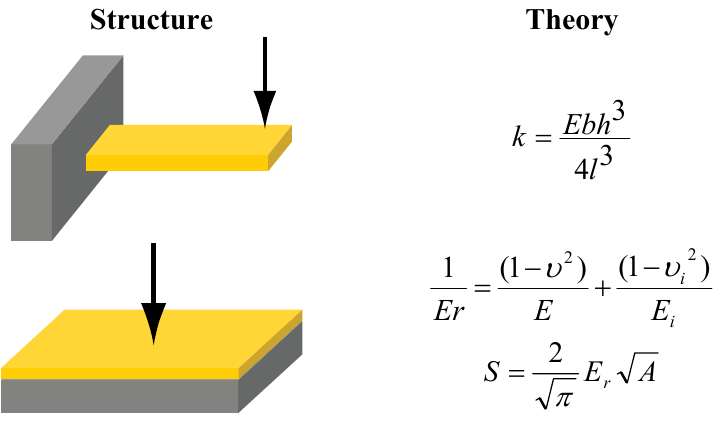
Figure 10. Illustration of various mechanical characterization methods and structure employed. In the cantilever elastic modulus calculation, E is elastic modulus, b is beam width, h is film thickness, l is distance between point of measurement and beam pivot point, and k is measured beam stiffness. In the blanket film elastic modulus calculation, υ and υ are Poisson’s ratios of film and indenter tip respectively, and E and E are elastic i i moduli of film and indenter tip respectively. In the calibration equation, S is measured stiffness, A is tip contact area, and E is reduced elastic modulus. Calibrations are usually r done on silica